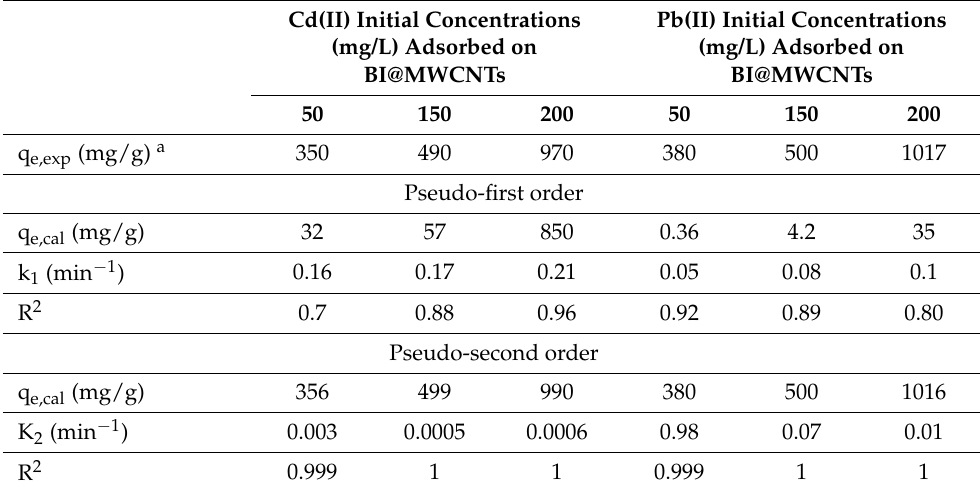
Table 3. The kinetic model parameters and determination coefficients for Pb 2+ and Cd 2+ adsorption